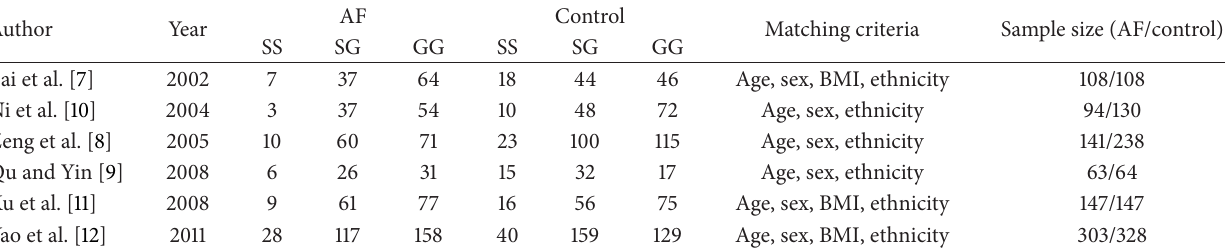
Table 1: Characteristics of the investigated studies of the association of Mink S38G gene polymorphism and atrial fibrillation (AF) in the Chinese population. Author